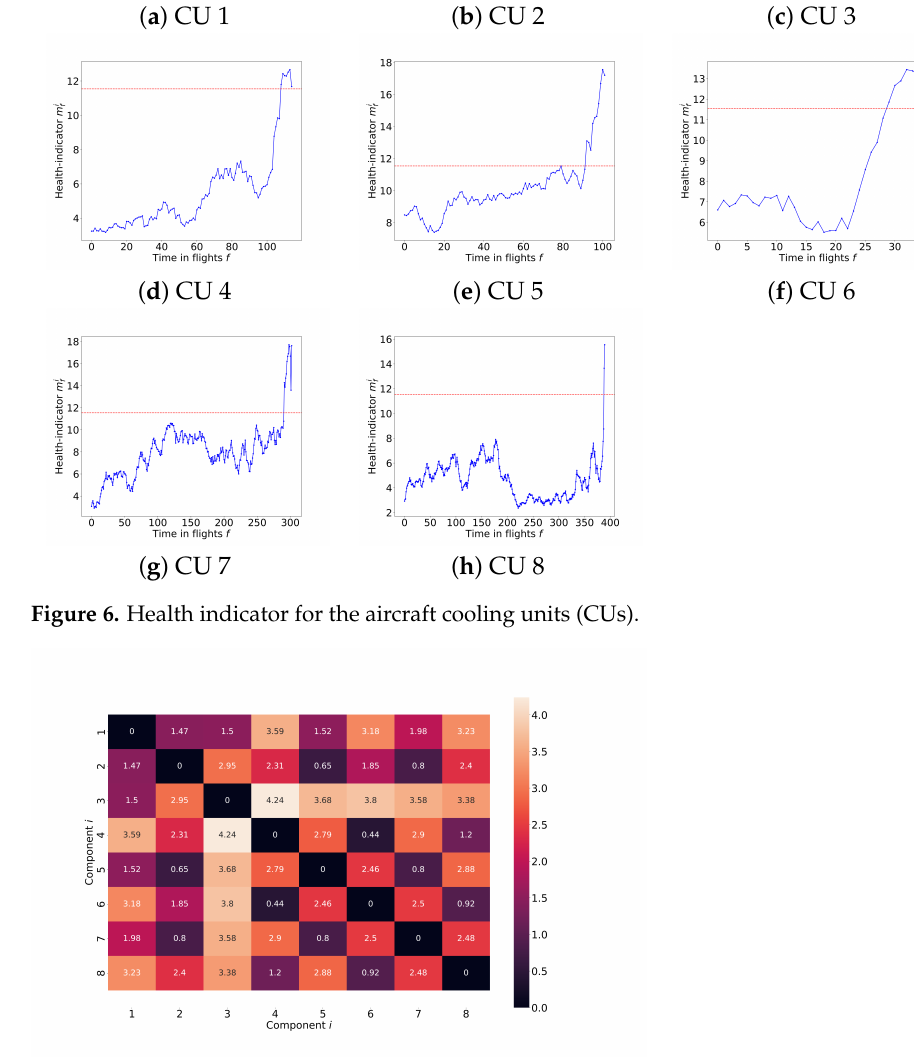
Figure 7. Heat map of the minimum Euclidean distance W ( I i , I j ) for the degradation trends of components i , j ∈ { 1,2, . . . ,8 }